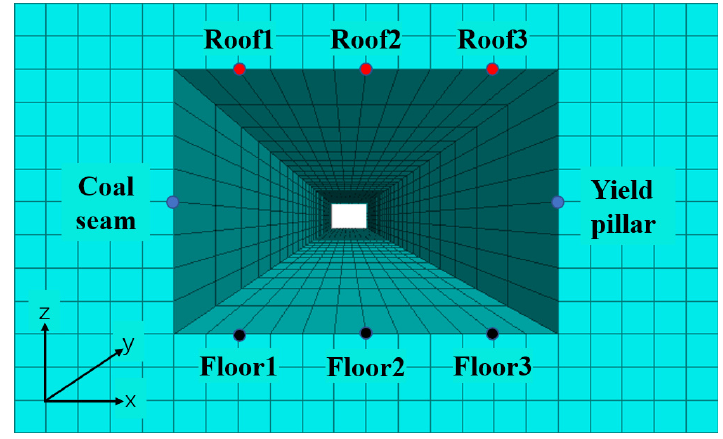
Figure 13. Layout of measuring points of roadway